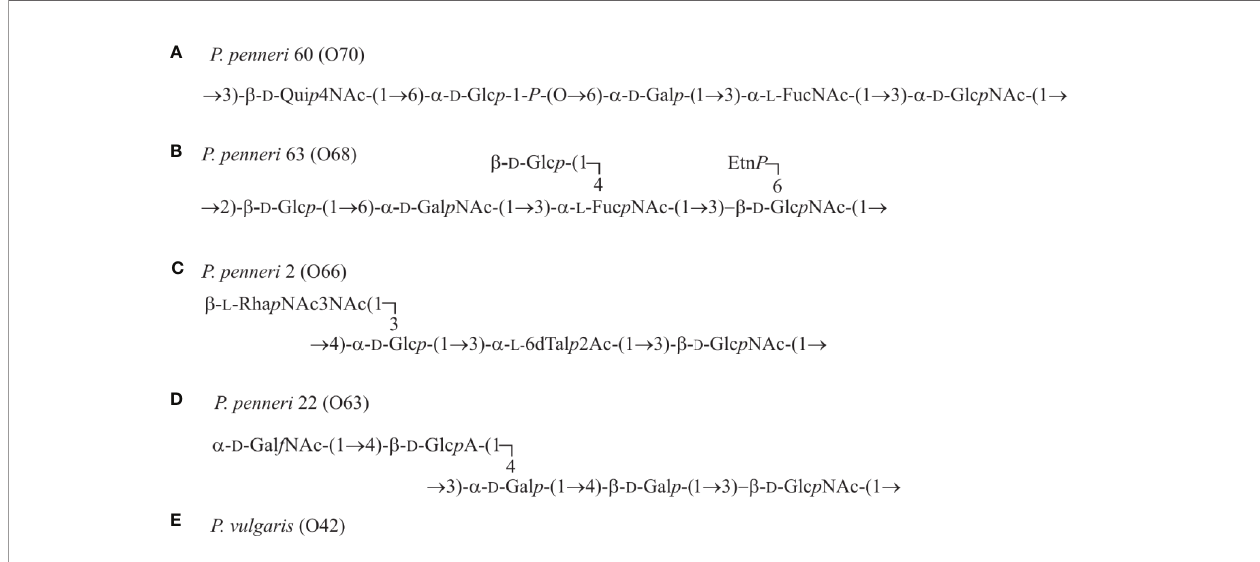
FIGURE 4 | Structures of the LPS O-polysaccharides of (A) P. penne ri 60 (O70), (B) P. penneri 63 (O68), (C) P. penneri 2 (O66), (D) P. penneri 22 (O63), and (E) P. vulgaris (O42) (Knirel et al.,